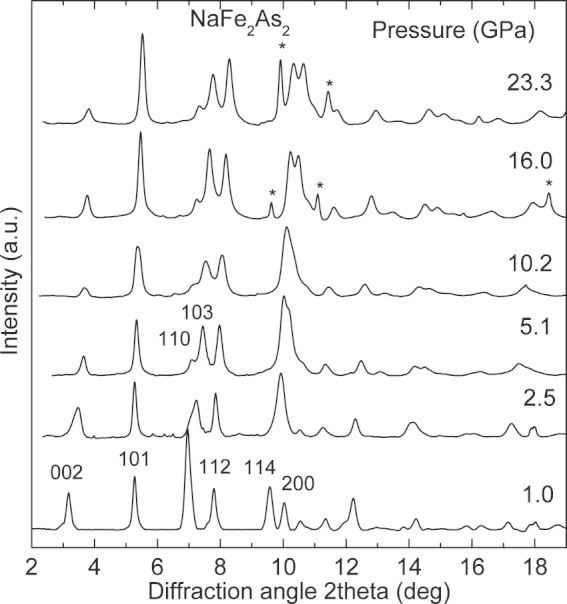
X-ray diffraction patterns of NaFe2As2 at various pressures. The asterisks denote peaks from Ne.